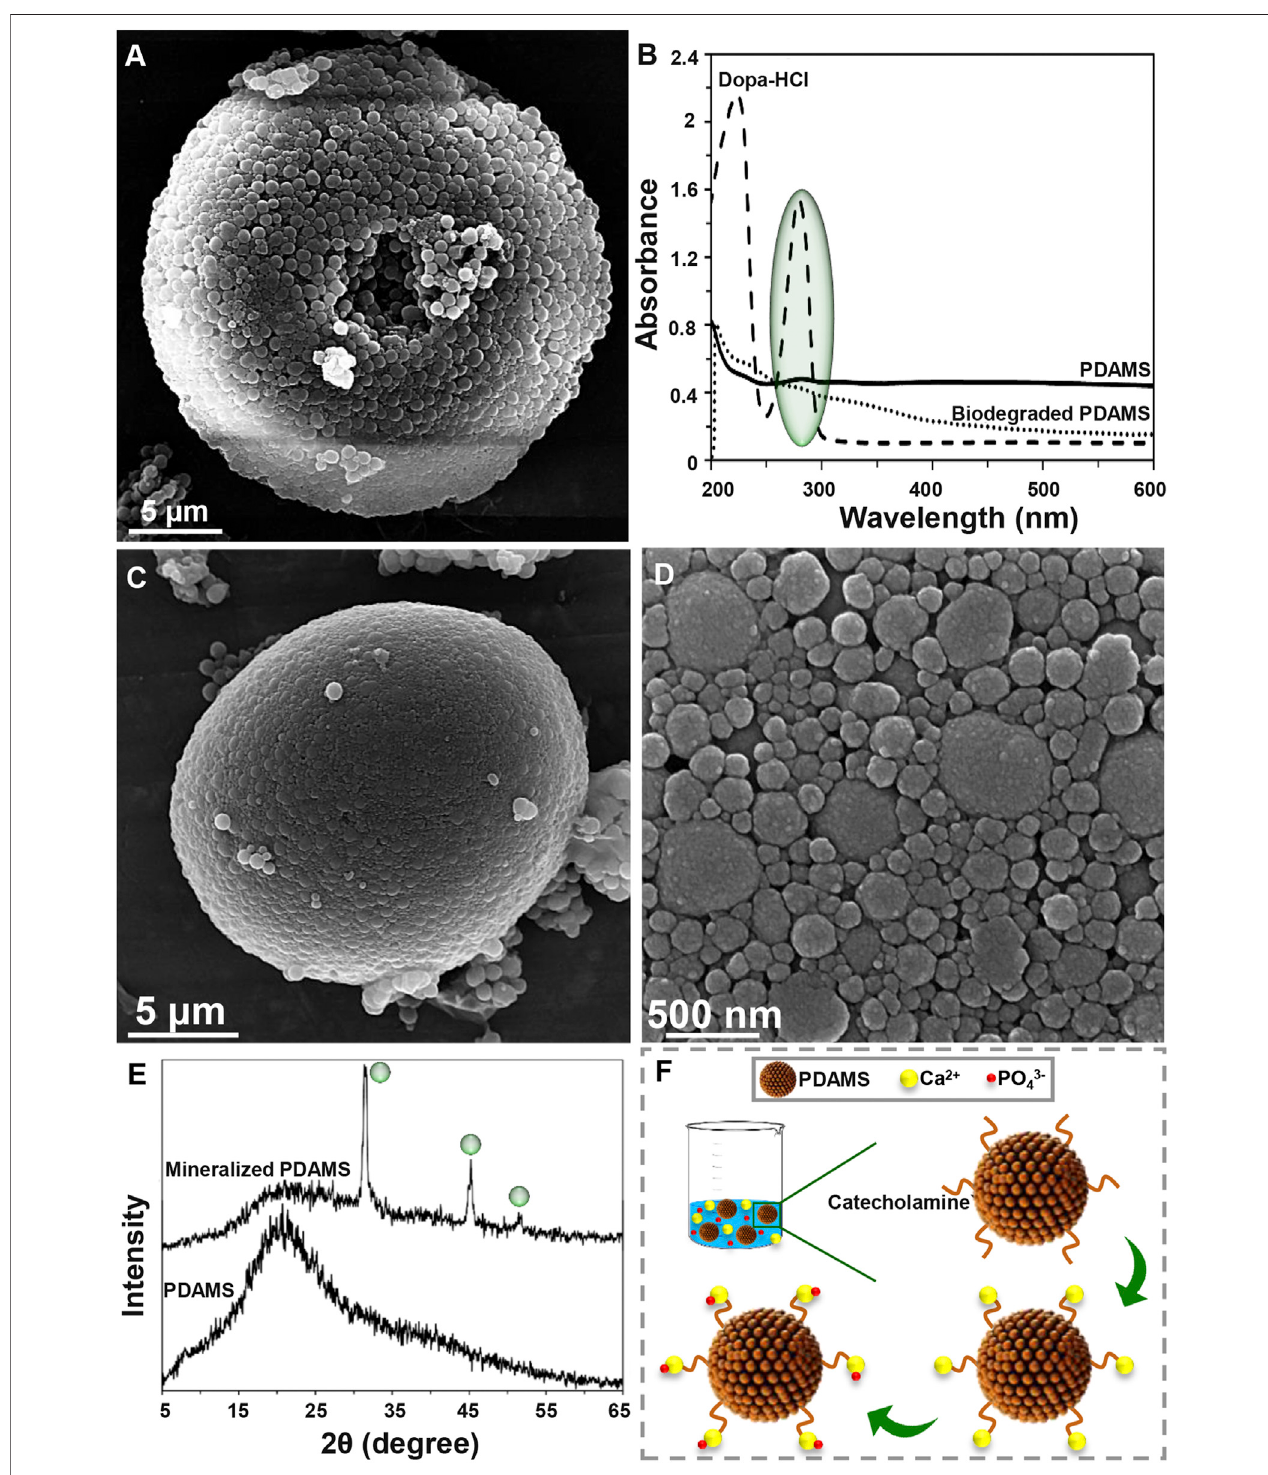
FIGURE 2 | Degradation and bioactivity of pomegranate-like PDAMS (A) FE-SEM image and (B) UV-VIS spectra of In-vitro degraded PDAMS after a 4-weeks immersion in the PBS solution (C, D) FE-SEM image and (E) XRD spectra of In-vitro biomimetic formation of hydroxyapatite-like layers on the PDAMS after a 4-weeks immersion in the SBF solution (F) Schematic of biomineralization of hydroxyapatite-like layers on PDAMS.